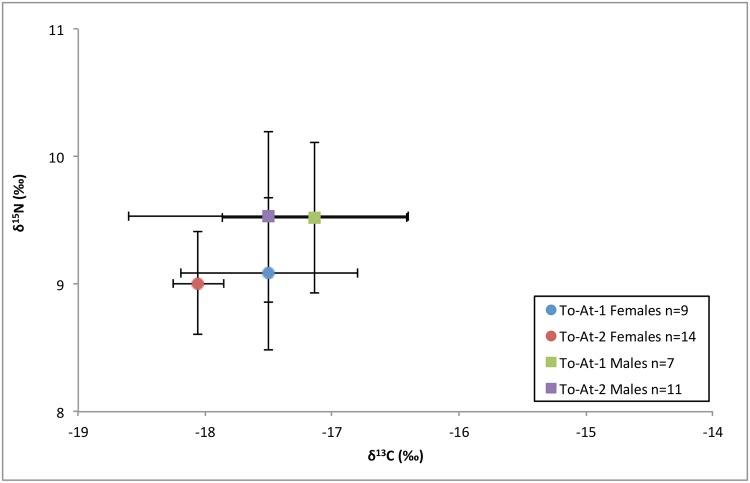
Mean (± 1SD) δ13C and δ15N results for sex and burial mound.